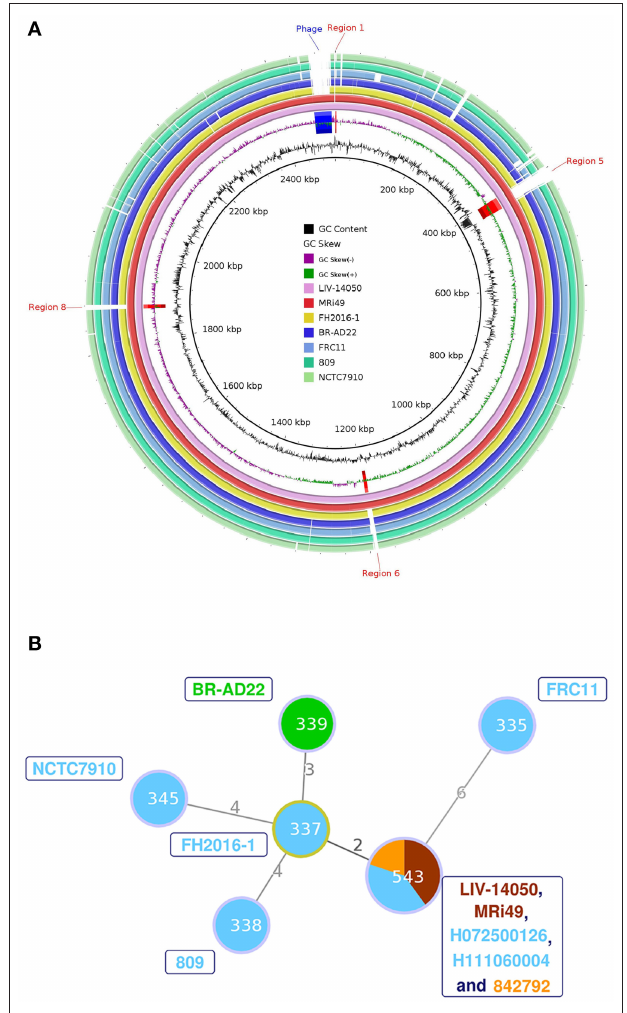
FIGURE 2 | (A) Circular genome diagrams were produced using BLAST Ring Image Generator (BRIG) version 0.95, which uses BLAST to align the genome sequences (24). The whole genome sequence of LIV-14050 was compared against six other genomes using NCBI’s online BLAST tool and visualized using the Artemis Comparison Tool (ACT) version 13.0.16 (22). Areas of the genome present in the ST453 sequences but not present in the other genomes were examined for coding sequences. A total of 24 regions and 29 genes were identified. Only the regions absent in all non-ST543 C. ulcerans genomes are annotated. (B) Minimum spanning tree diagram showing sequence types (STs) of LIV-14050, the six genomes compared in Figure 2A and the additional ST543 isolates previously reported. The size of the circle indicates the number of isolates with that ST in the data set. The colors within the circle indicate species the ST was isolated from: Human (blue); Equine (brown); Feline (orange); and Canine (green). The isolates represented by each ST are indicated by the same color labels next to the corresponding node. The numbers on the connecting edges indicate the number of nonmatching alleles between the two ST